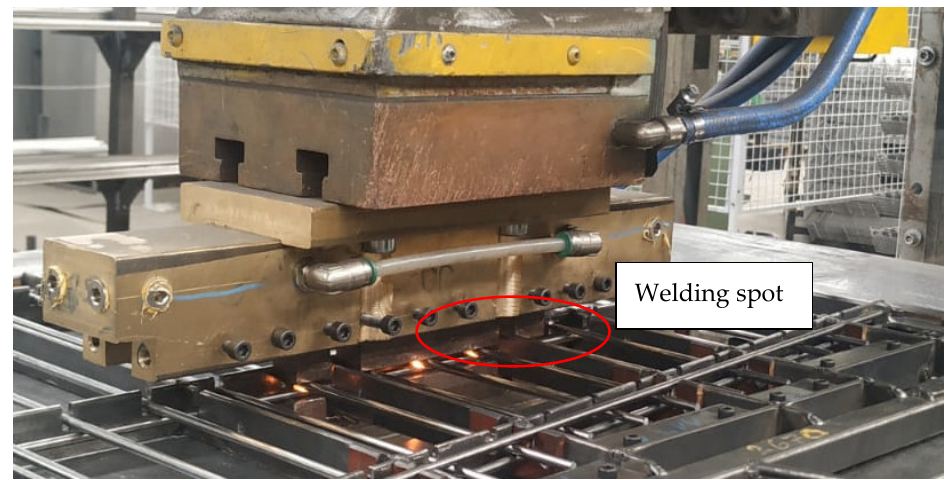
Figure 2. Process of crosswire welding with indicated welding spot.